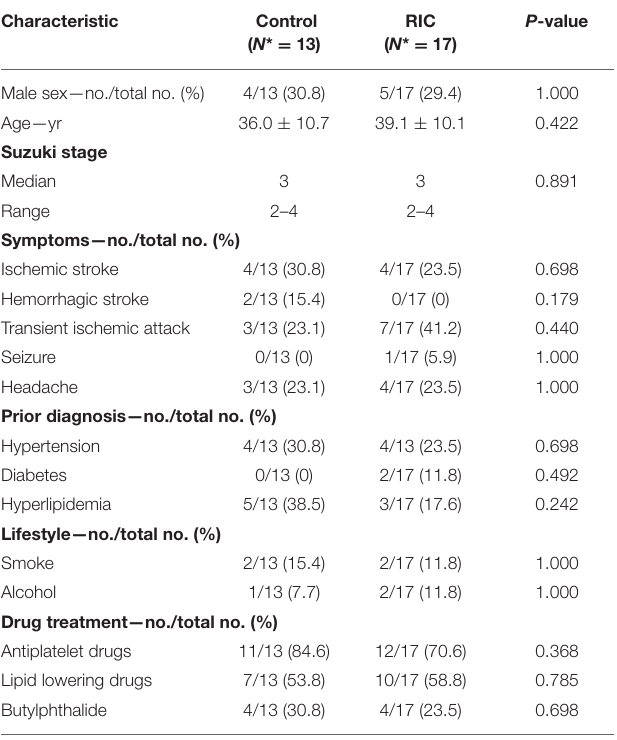
TABLE 1 | Baseline characteristics of the patients with moyamoya disease (MMD). Characteristic